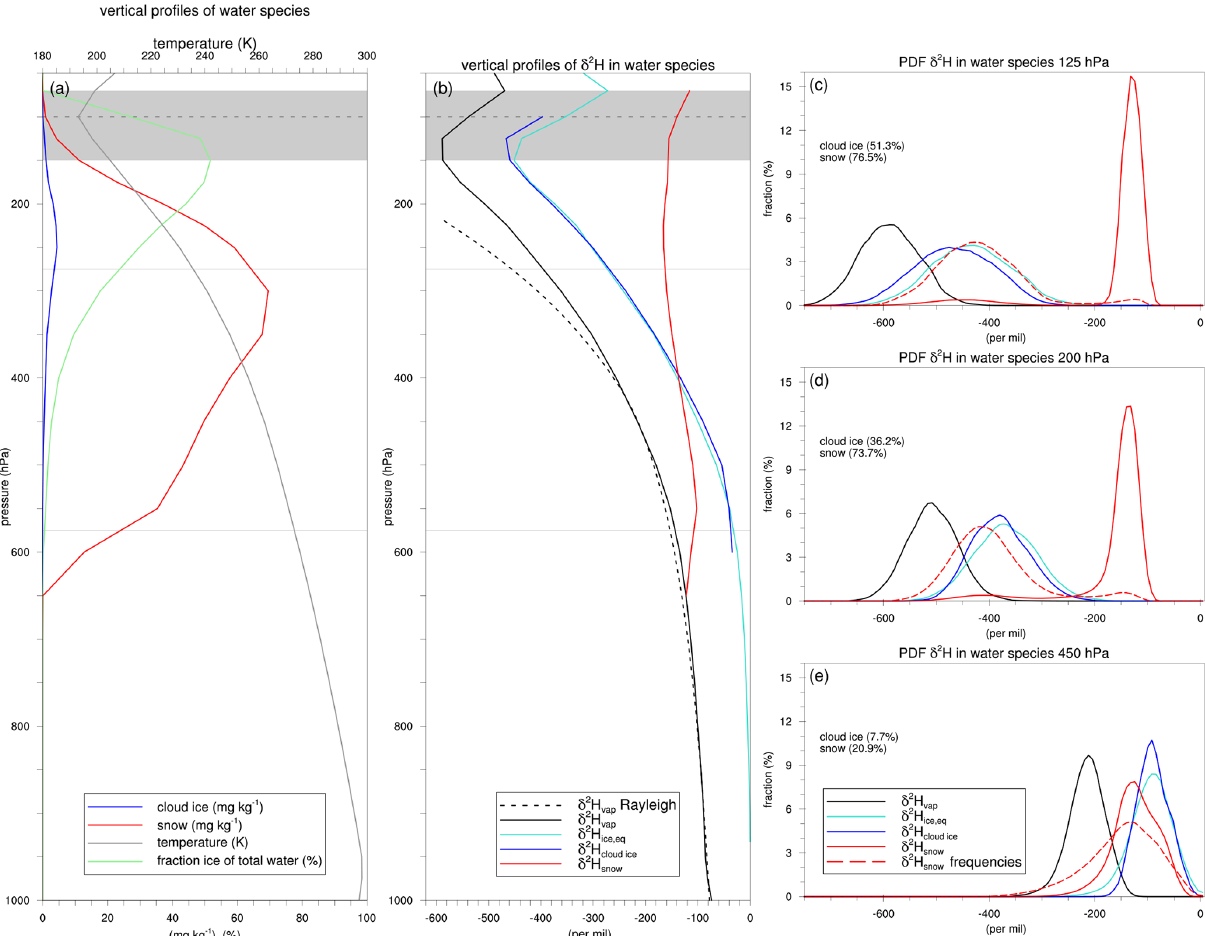
Figure 8. Vertical profiles and probability density functions (PDFs) of water species and their isotopic composition in the target region (5–20 ◦ N, 10 ◦ W–20 ◦ E; see black box in Fig. 1) for July 2016. Panels (a) and (b) show vertical profiles of domain average values of (a) temperature, cloud ice, snow, and the fraction of summed cloud ice and snow of total water and of (b) δ 2 H (‰) in vapour, equilibrium ice, cloud ice, and snow, as indicated by the legend. The black dashed line in panel (b) is δ 2 H (‰) in vapour as predicted by Rayleigh distillation for moist adiabatic ascent of a saturated air parcel at 1000hPa with a temperature of 25 ◦ C. In panels (c) – (e) , the mass-based PDFs of δ 2 H in water species at 125, 200, and 450hPa are shown and are complemented by the frequency-based PDFs of snow (red dashed line). The δ 2 H in cloud ice and snow, shown in panels (c) – (e) , is based on grid points with cloud ice and snow content ≥ 10 − 4 mgkg − 1 . The fractions of these grid points with respect to all grid points at the respective levels are stated in the text in these